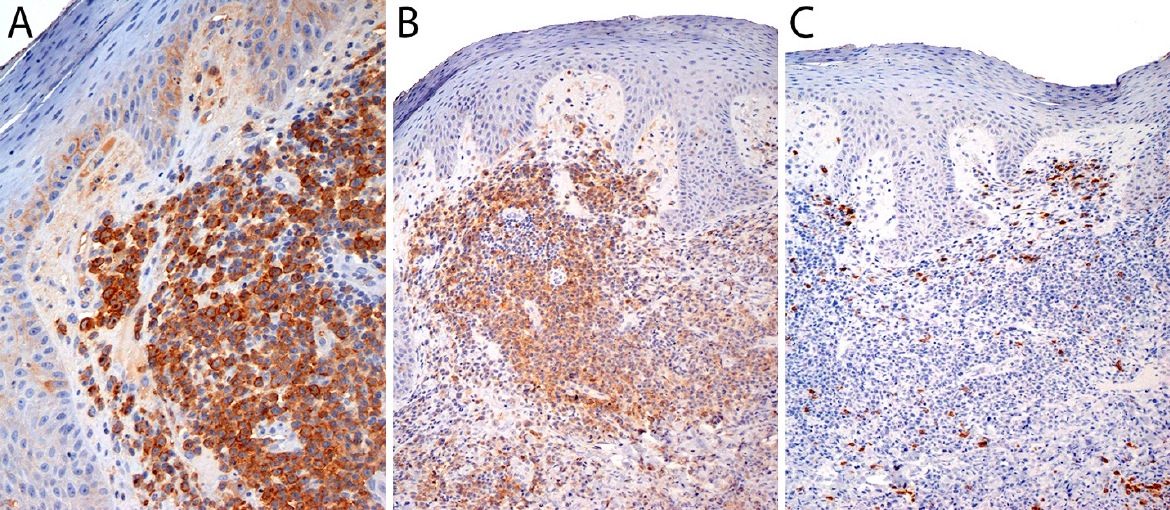
Figure 15. Immunohistochemical findings in primary cutaneous ALCL. The tumor cells are diffusely positive for ( A ) CD30 with a membranous and Golgi (dot-like) pattern. The tumor cells are positive for ( B ) CD4, and negative for ( C ) CD8.